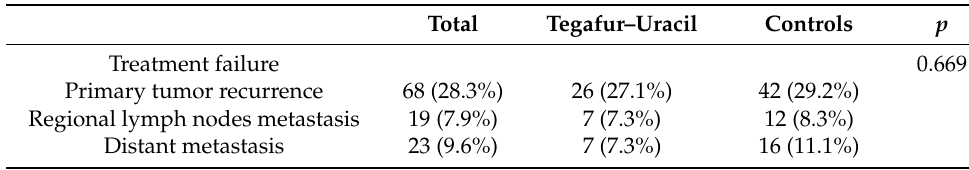
Table 3. Treatment failure ( n =